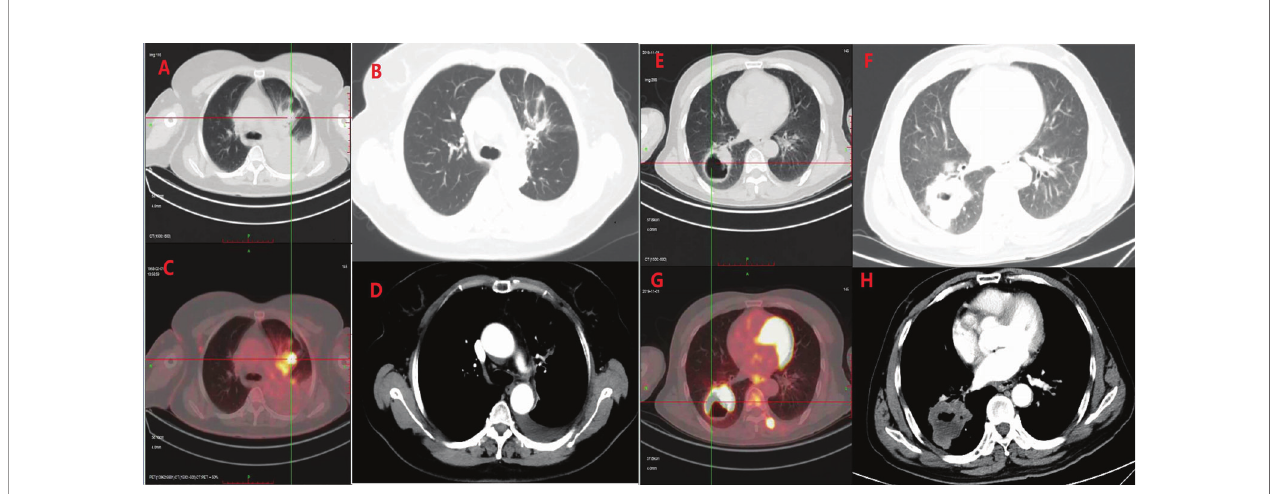
FIGURE 1 | (A) A 63-year-old female patient with stage IVa left upper lobe adenocarcinoma. PET-CT before immunization and chemotherapy showed a SUVmax of 11.0 and an LDH of 196 (A, C) . The imaging ef fi cacy evaluation after 6 cycles of treatment showed PR (B, D) . (B) A 58-year-old male patient with squamous cell carcinoma of the right lower lobe, PET-CT showed SUVmax of 22.8, LDH of 196 (E, G) , and disease progression (F, H) after 4 cycles of treatment.